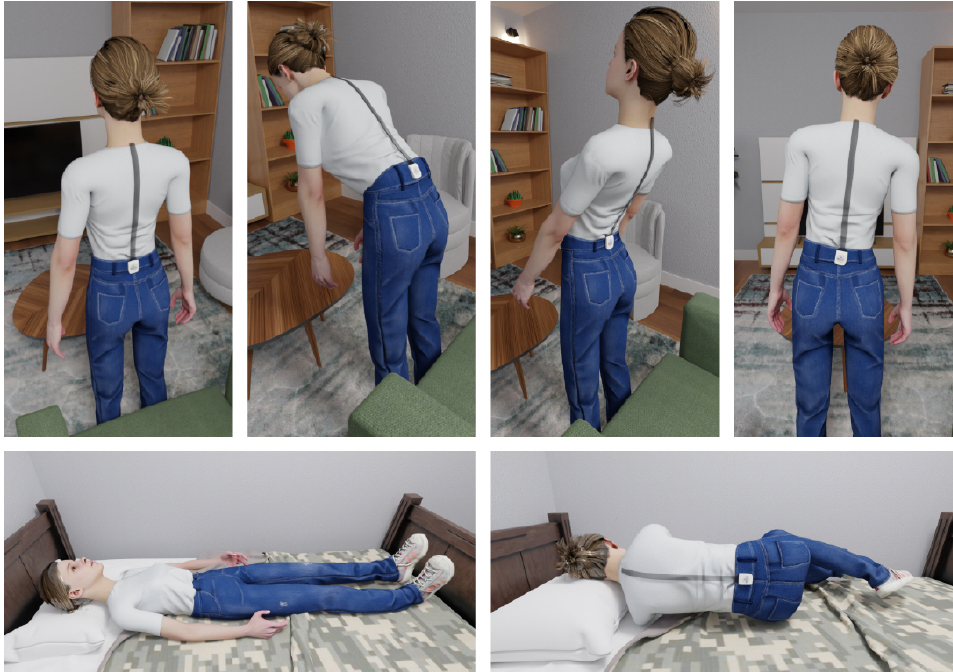
Figure 2. Top row from left to right: standing, BF, BB, and BR. Bottom row from left to right: supine and LLD positions. The study design included comprehensive physical activities contributing in wide-range of